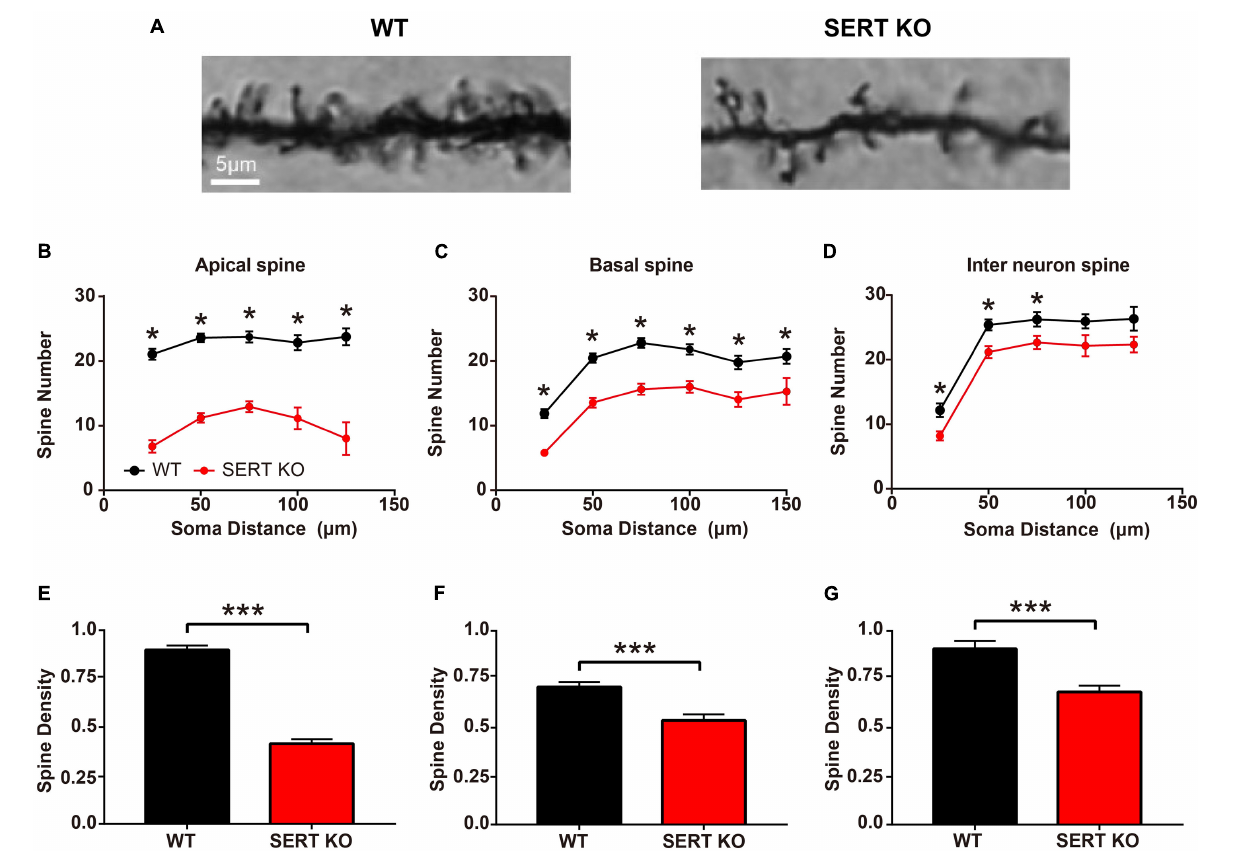
FIGURE 3 | Dendritic spines density decreased in serotonin transporter (SERT) knockout (KO) mice. (A) Representative photomicrographs of dendritic spines of basal dendrites in layer IV pyramidal neurons from wild-type (WT) and SERT KO mice. (B,C) Comparing the total number of apical and basal dendritic spines at a distance of per 25 µ m from the cell body of layer IV pyramidal cells in WT mice with SERT KO mice, respectively. (D) Comparing the total number of dendritic spines at a distance of per 25 µ m from the cell body of layer II/III interneurons in WT mice with SERT KO mice. (E–G) The dendritic spine densities of apical and basal dendrites in layer IV pyramidal neurons and in layer II/III interneurons of the auditory cortex. Data are presented as means ± SD. n = 6 for each group. * p < 0.05, *** p < 0.001, Student’s t -test and two-way ANOVA. Scale bar: 5 µ